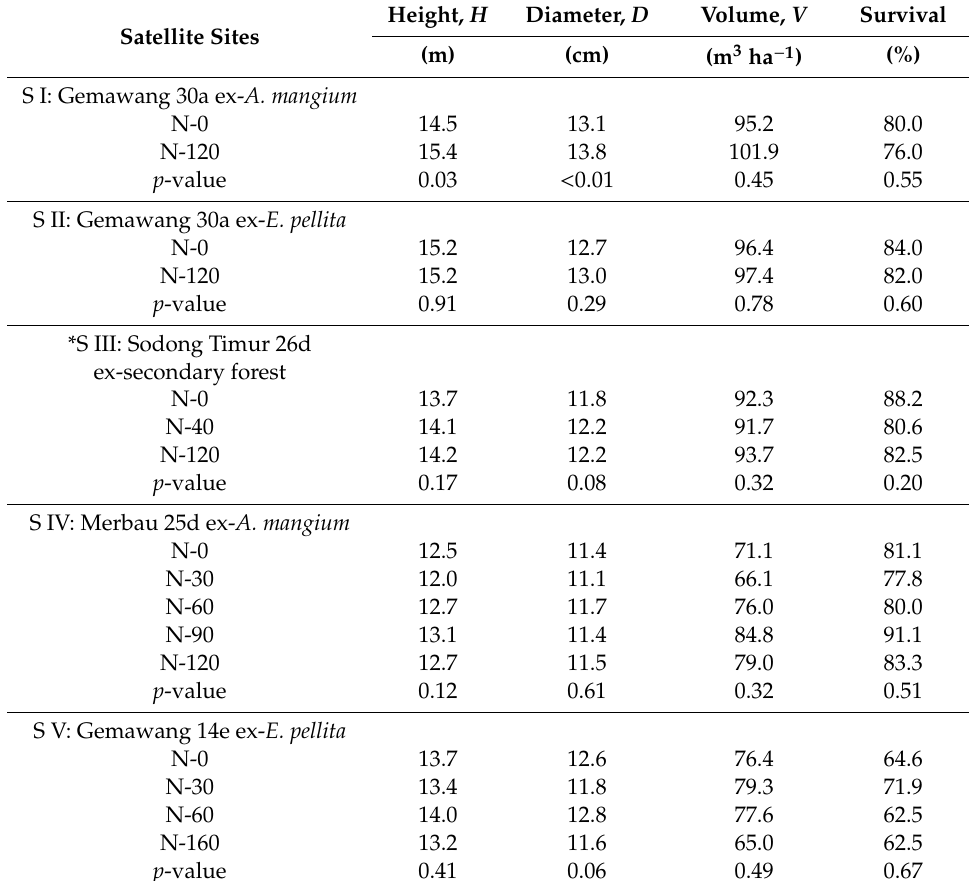
Table 5. Response to application of N fertiliser at the Satellite sites at 3 years of age. Height, H Diameter, D Volume, V Satellite Sites